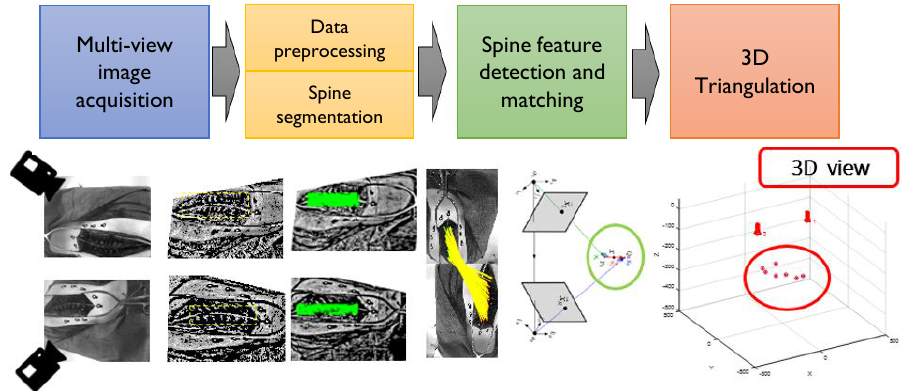
Figure 3. Proposed framework for 3D spine feature